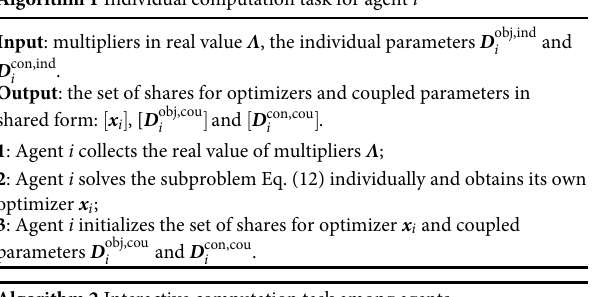
Algorithm 2 Interactive computation task among agents